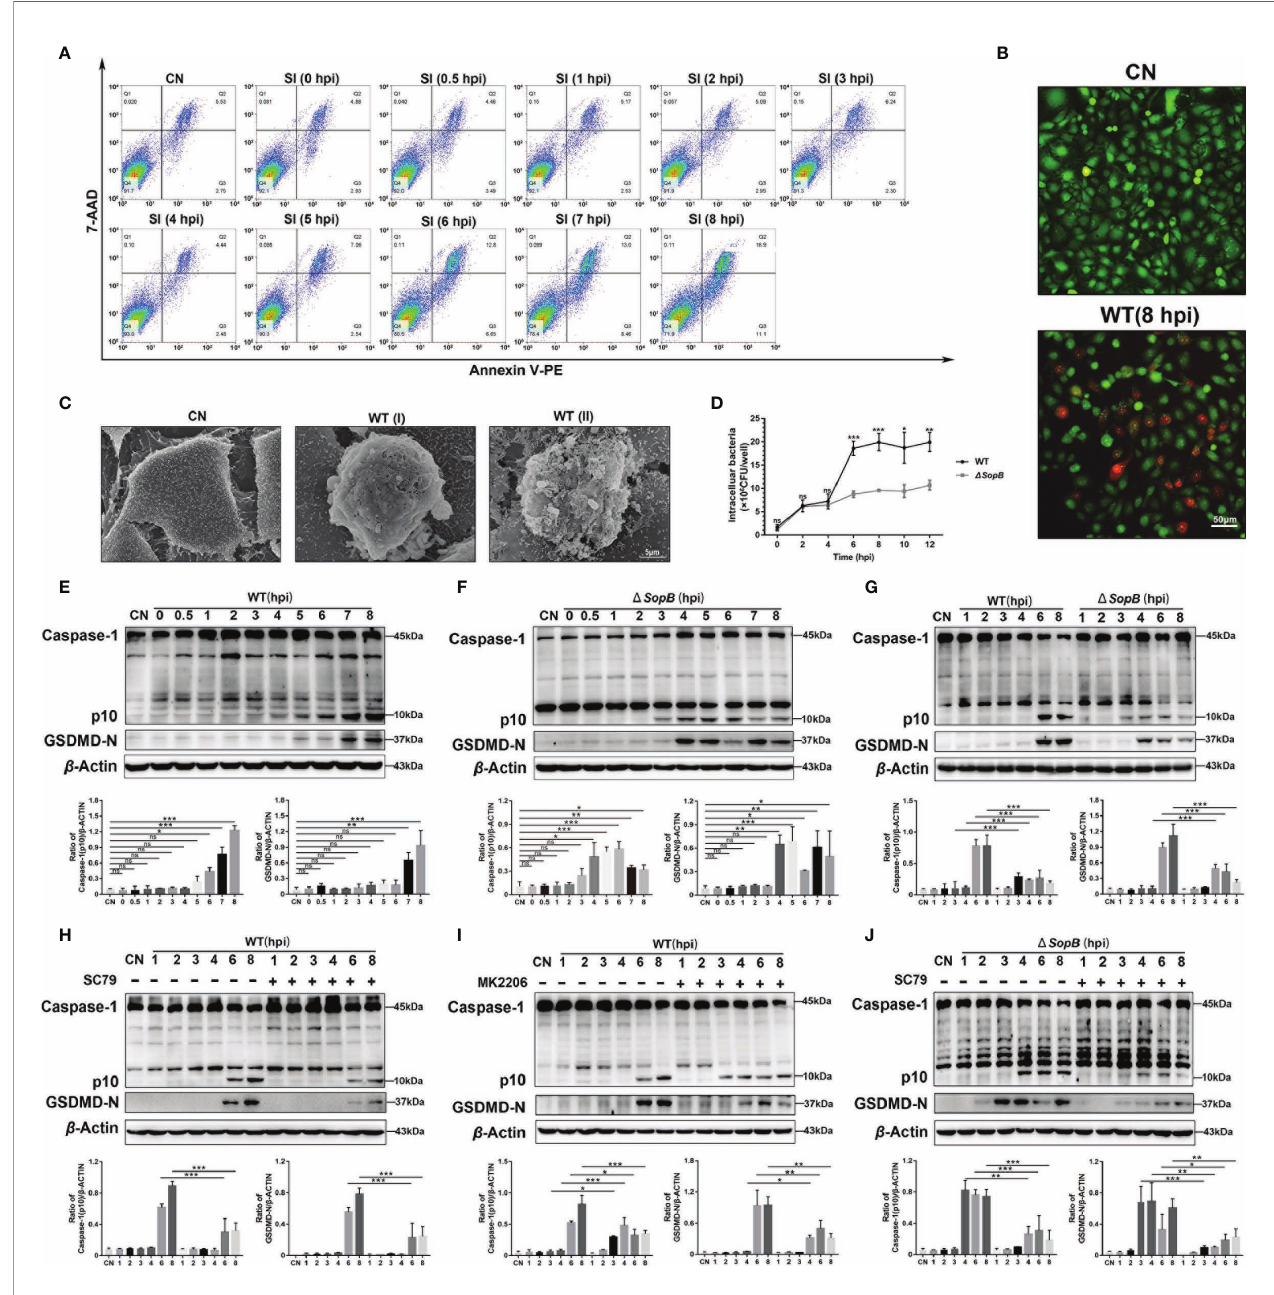
FIGURE 5 | SopB -mediated Akt phosphorylation delayed pyroptosis. (A) The proportion of apoptotic cells within 8 h after infection with WT S . Infantis was detected using fl ow cytometry. (B) Calcein-AM/PI was used to evaluate cell membrane permeability after 8 h of infection with WT S . Infantis. Green: Calcein-AM; Red: PI. (C) Observation of the apical surface of Caco-2 cell monolayer ultrastructure using scanning electron microscopy. WT (I) (6 hpi) and WT (II) (8 hpi) showed that the WT S . Infantis – infected cell was bacteria-laden, which were extruded from the monolayer. (D) Detection of intracellular bacterial load using the gentamicin protection assay at 0, 2, 4, 6, 8, 10, and 12 hpi after infection (Black curve: WT S . Infantis; Gray curve: SopB mutant). (E – J) Western blot analysis of Caspase-1 and GSDMD-N protein levels after infection with WT S . Infantis or the SopB mutant within 8 h. (E) Infection with WT S . Infantis; (F) infection with the SopB mutant; (G) comparison of WT S . Infantis and the SopB mutant; (H) infection with WT S . Infantis in the presence of SC79; (I) infection with WT S . Infantis in the presence of MK2206; (J) infection with the SopB mutant infection in the presence of SC79. Data were presented as the mean ± SEM from three independent experiments (n = 3). * P < 0.05, ** P < 0.01, *** P < 0.001. CN, control; SI, S . Infantis. ns, no signi fi cant